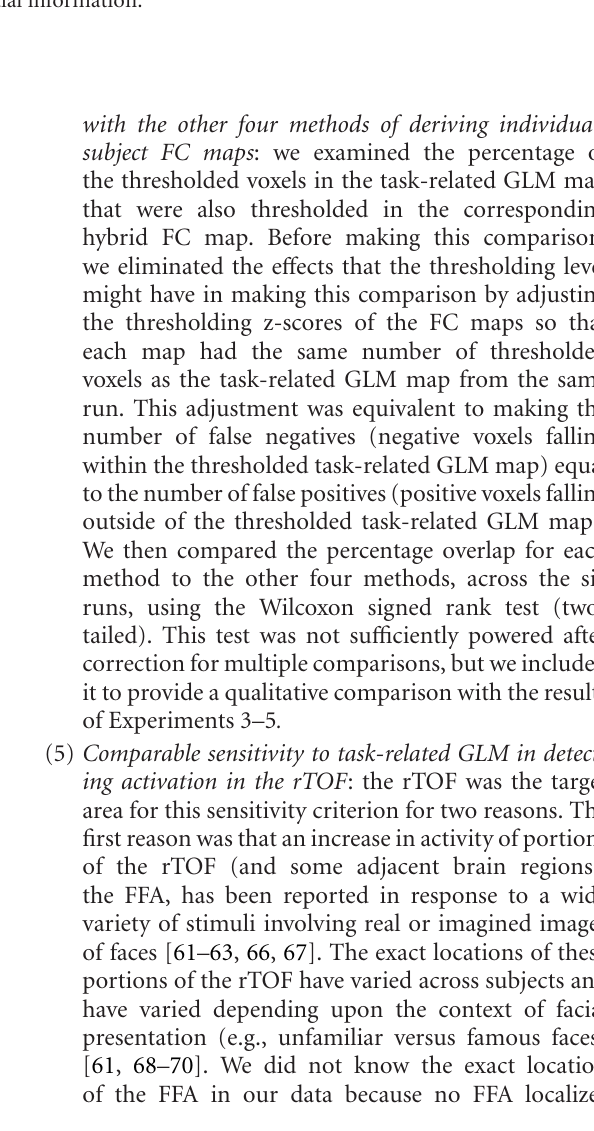
Figure 4: Spatial maps and time courses for Run 2: (a) task-related GLM; hybrid ICA-seed-based approaches, using the average time course from (b) a single voxel, (c) a few voxels, or (d) many voxels; and dual regression using seed spatial information from (e) an IC spatial map or (f) an entire set of IC spatial maps. Run 3 was the source of seed spatial